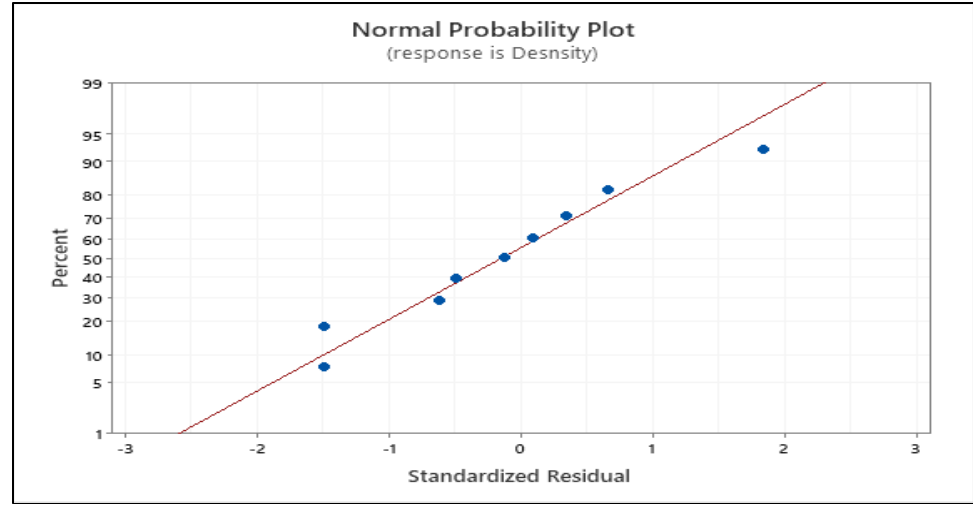
Figure 4. Normal probability plot of the residuals for C d .